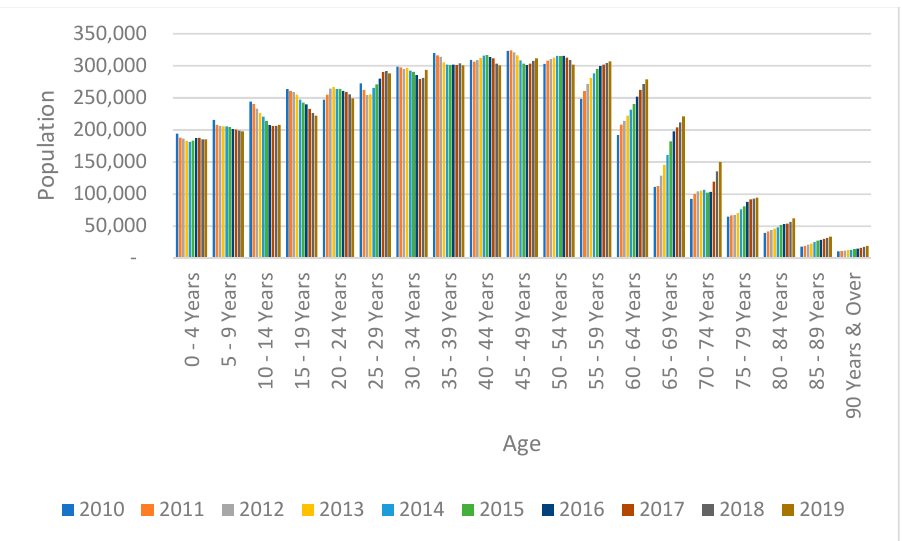
Figure 2. Singapore Residents by Age Group: 2010 to 2019. Source: Developed for the study.